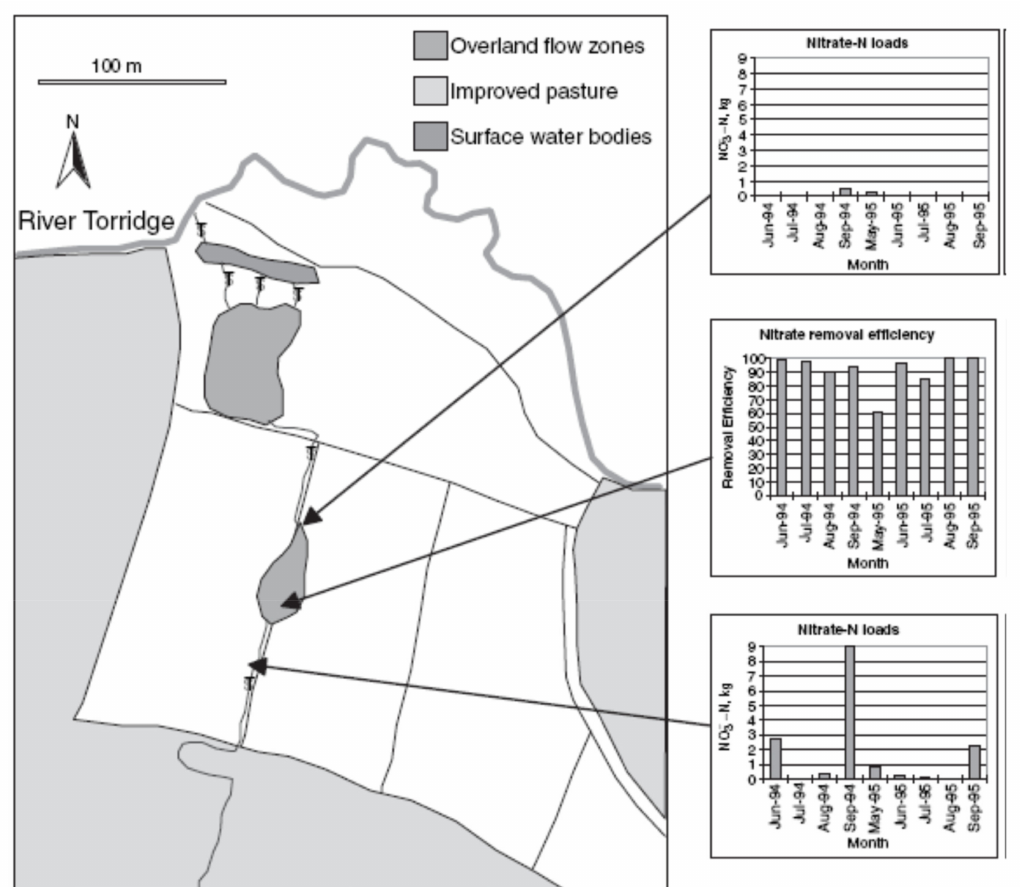
Figure 31. Incongruity between wetland science and policy in which river marginal wetlands running parallel to the channel may not necessarily offer the most effective buffers against nitrate pollution of freshwaters. The graphs show reduced levels of nitrate at locations along the runoff flow line from the source in agricultural fields and at right angles to the alignment of the channel. The grey shaded areas are particularly effective wetland hotspots for nitrate reduction especially by denitrification [88].